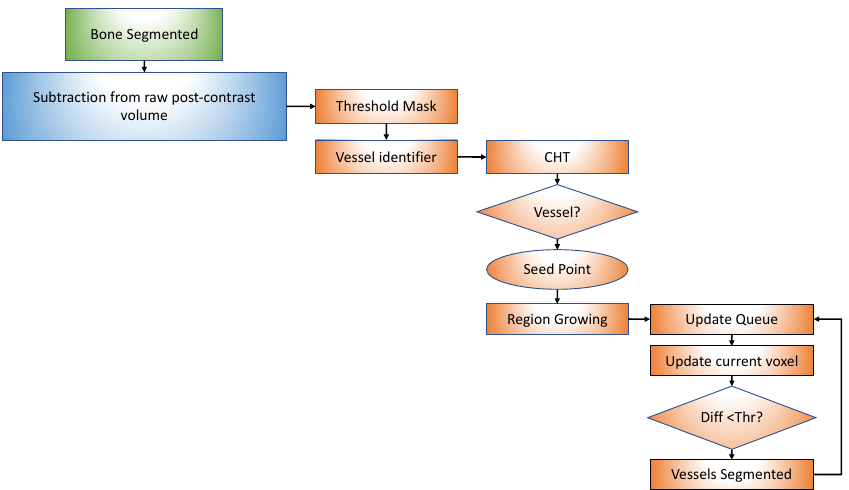
Figure 2. Overview of the blood vessel segmentation